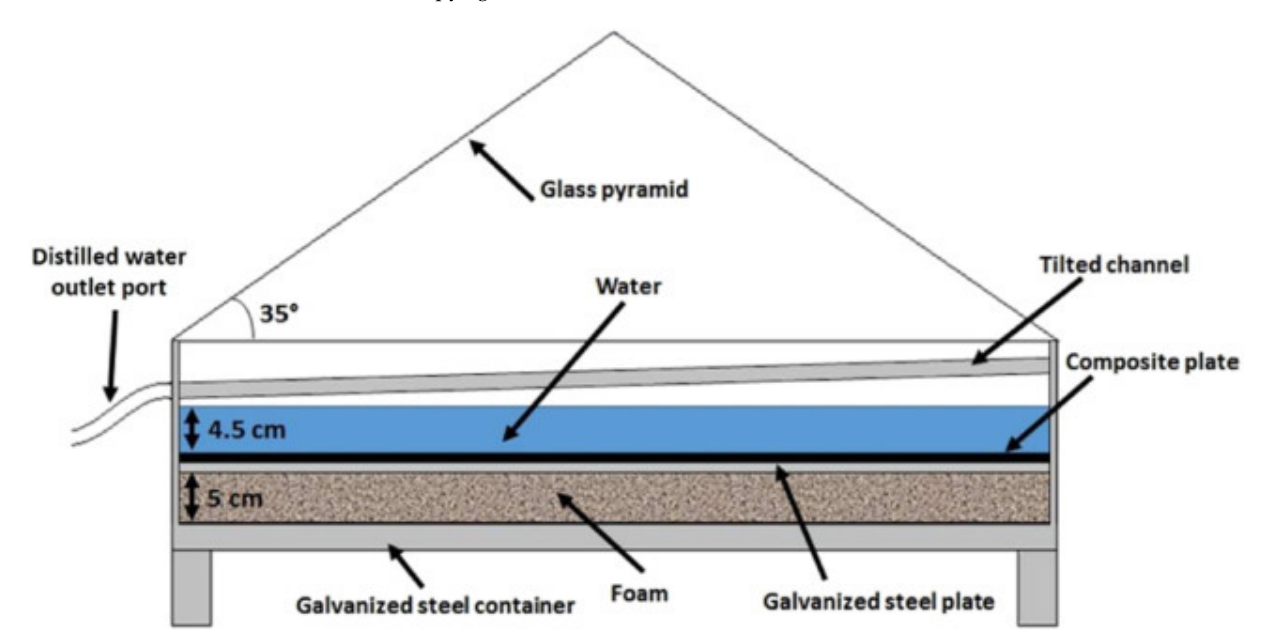
Figure 10. A pyramid quadratic solar system (adapted with permission from Reference [55], Copy- right 2017, Elsevier).